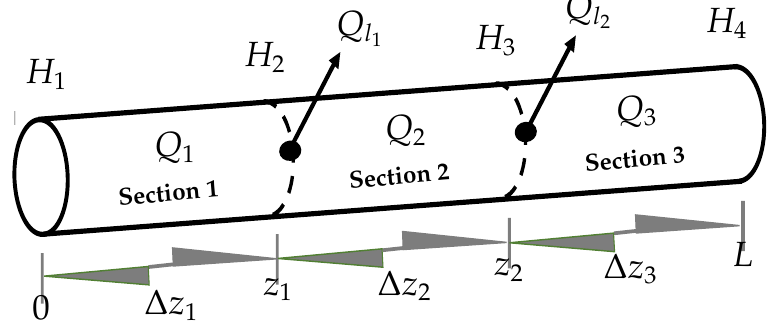
Figure 2. Discretization of the pipeline with two arbitrarily located leaks.